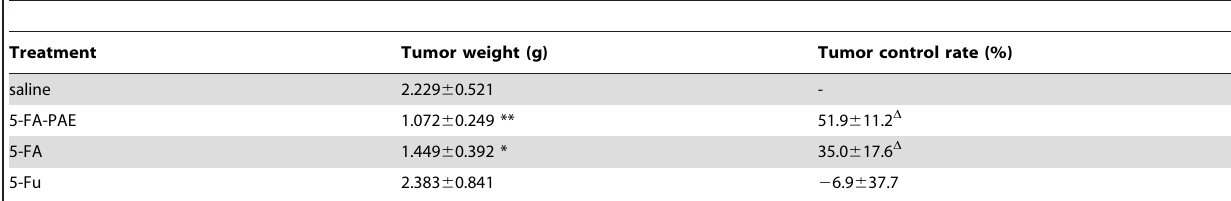
Table 4. Tumor weight and tumor control rate of mice administrated with saline, 5-Fu, 5-FA or 5-FA-PAE.